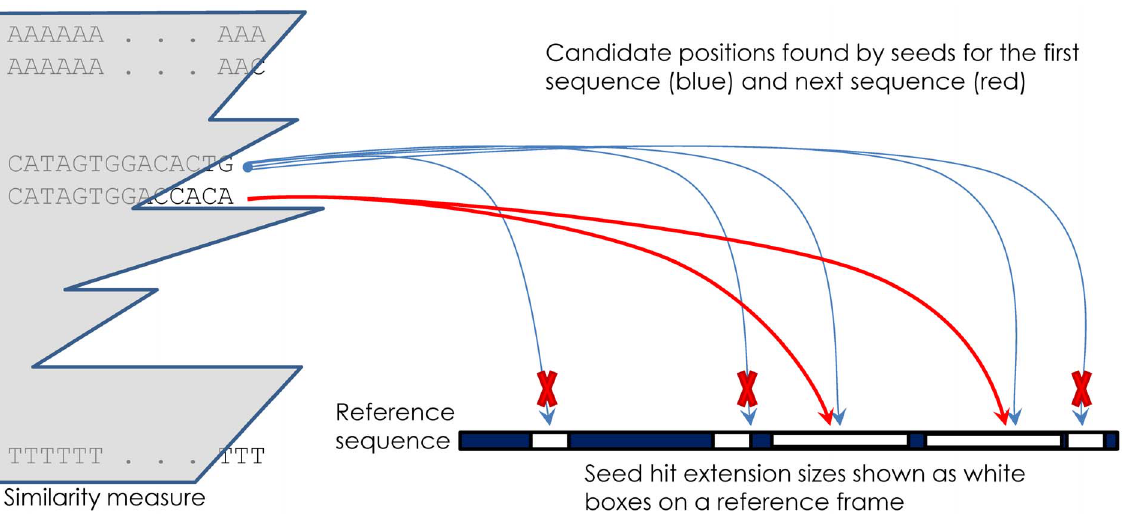
Figure 5. Cross-similarity decreases the pool of optimal alignment candidates. In this example, the first sequence CATAGTGGACACTG has generated 5 possible hit candidate positions (blue arrows), but only three of those have failed to extend or align long enough (marked by X ). The next sequence, CATAGTGGACCACA, having a significant length of prefix similar to the prior one, does not need to consider all candidate positions, and can specifically exclude from consideration those for which the extension attempt failed with a wide margin of error for the prior, similar sequence. Table S2 All Run Counts. A detailed spreadsheet containing all counts of alignments (and unaligned sequences) used to summarize the validation and testing section. Table S3 generateSeqs. Provides the text of a short script written to generate the random subset of reads used in the validation and testing. Table S4 Externalvs.HIVE Bowtie&BWA. Shows the compared alignment counts of external tools when run both inside the HIVE environment and in their native external environments. Table S5 Access Data in HIVE. Provides access information and instruction for reviewers and other interested individuals to see and replicate the results presented herein.